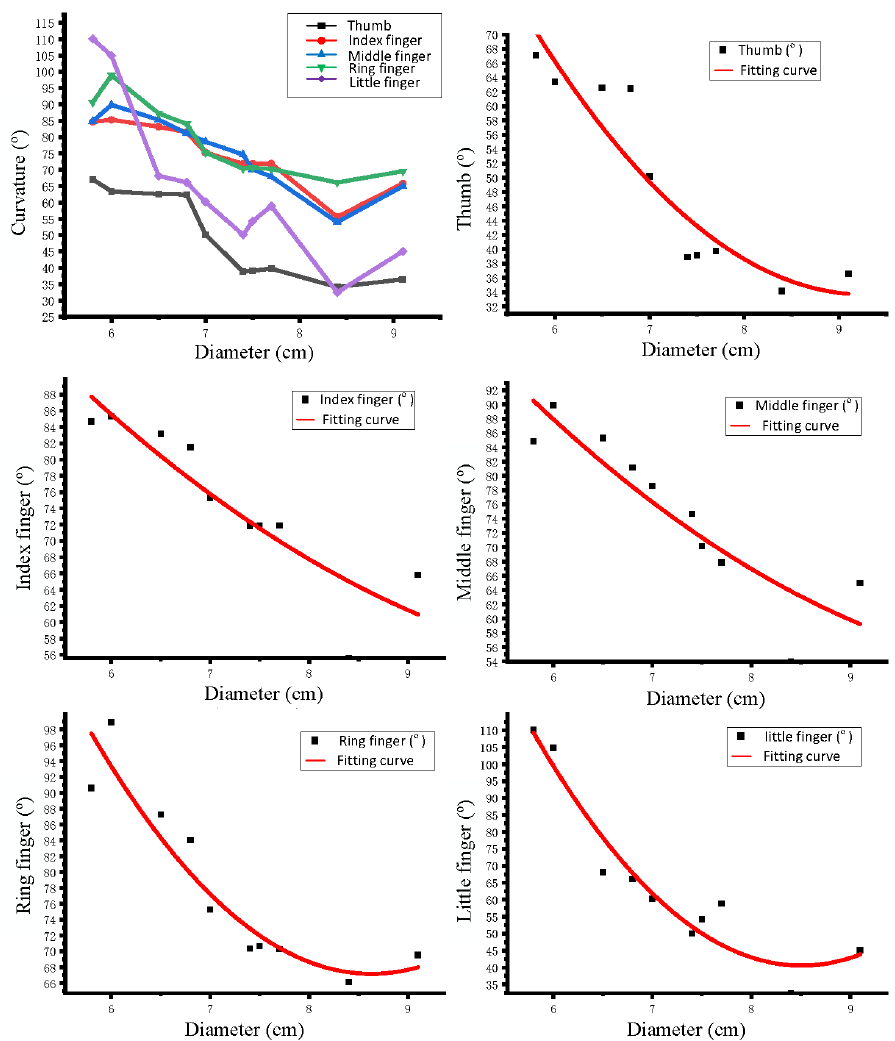
Figure 7. Fitting relationship between finger curvature and diameter.